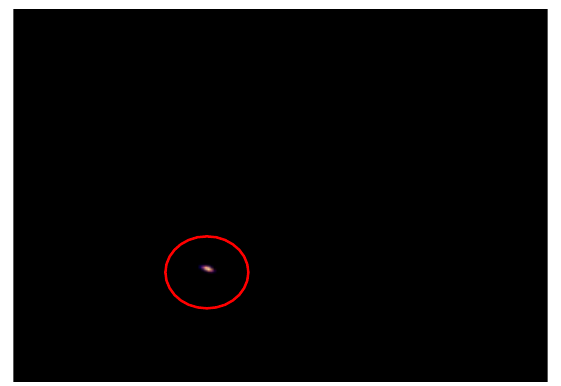
Fig. 7 . Amplitude image MOSFET transistor with thermal adjustment